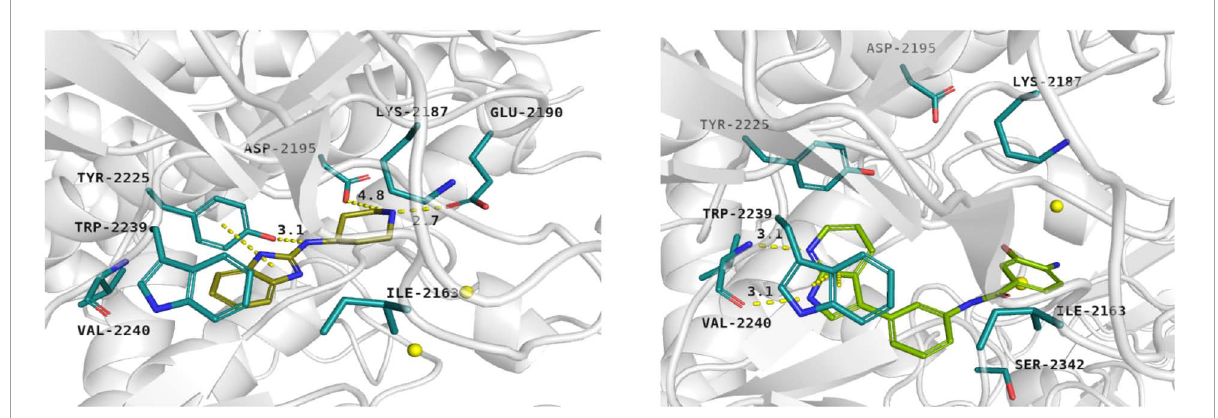
FIGURE2 Binding mode of compound 1 (left panel) and compound 3 (right panel) within the ATP binding site of mTOR. Magnesium ions – yellow spheres. Selected interactions between ligands and residues colored as yellow